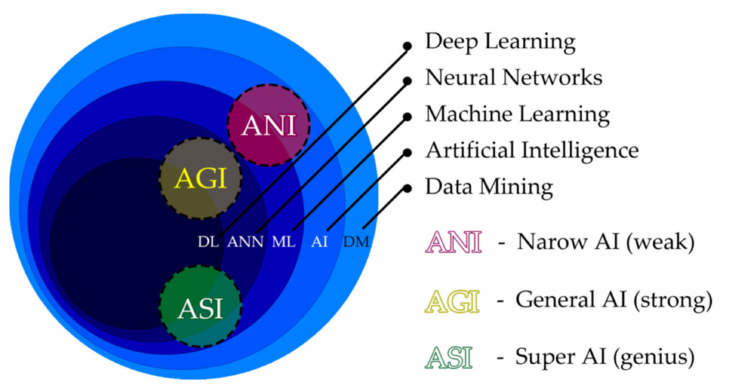
Figure 2. General AI categorization defines three types: artificial narrow intelligence (ANI), artificial general intelligence (AGI), and artificial super intelligence